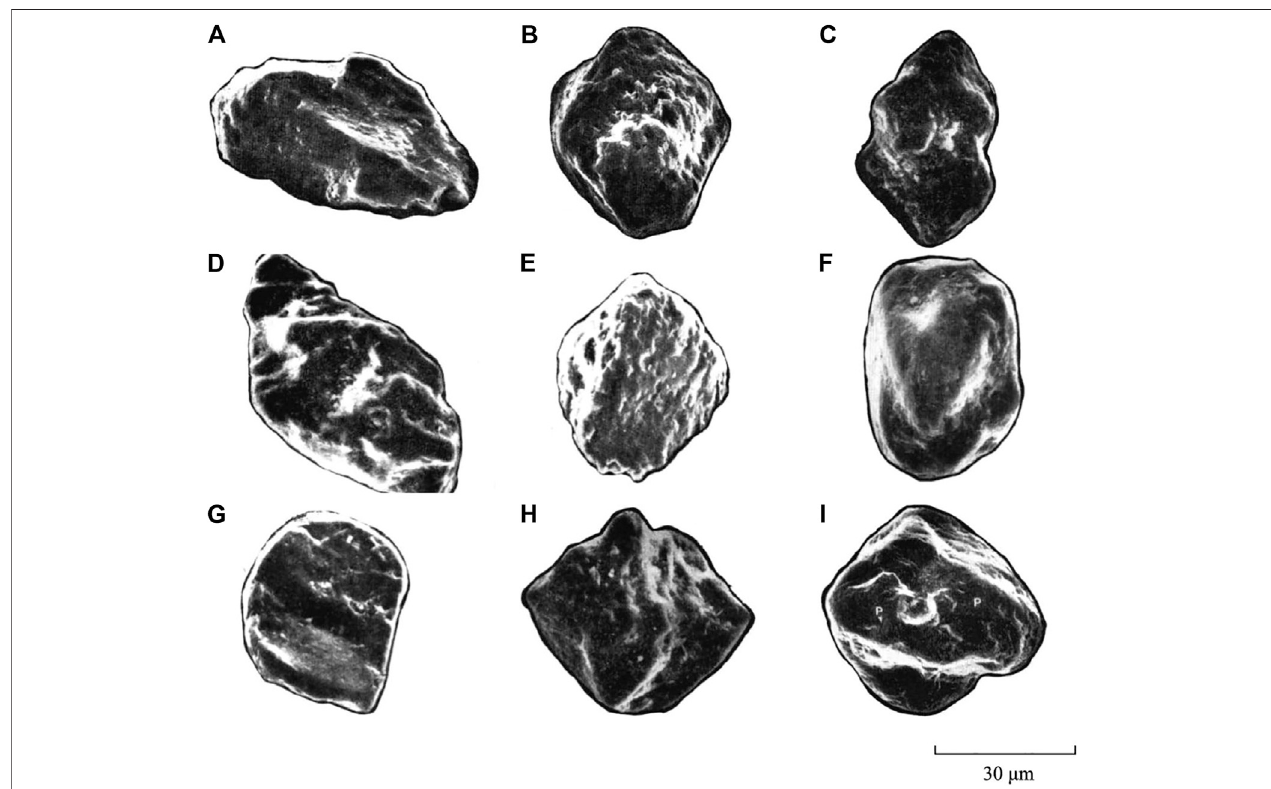
FIGURE9| QuartzgrainsoftheloessontheCLP. (A) .Streamlinedgrainwithprecipitatedsilica. (B) .Spear-shapedgrainwithathick layerofsilicaprecipitatesand pockmarked surfaces, small collision pocks are visible on the original surface. (C) . Fusiform grain with silica precipitation. (D) . A fusiform - twisted grain with a thick precipitatedsilicacover.ThestreamlinedgrainischaracteristicoftheaeolianquartzgrainofloessontheCLP.Thescrew-likeshapeofthisgrainistypicalofaeolianloess that has been transported by air currents in suspension for a long distance. (E) . Lenticular grain with solution - precipitation features covering the surface. (F) . Ellipsoidal grain with chipped depressions and smooth outline. (G) . A typical water - drop-shaped grain, smooth edges with one edge along the long axis. The grain surface carries chipped depressions, collision pocks and silica fragments. (H) . Lenticular-shaped grain with solution-precipitation of silica. (I) . Equant grain with subrounded edges, chipped depressions and collision pocks are common on the surface (Wang et al., 1985).